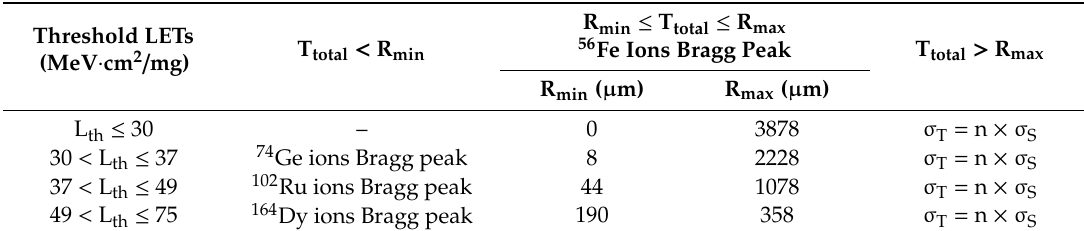
Table 1. The heavy-ion radiation test guidance for 3D vertically stacked devices, where T total is the sum of (n − 1) T 2D , T p and T s